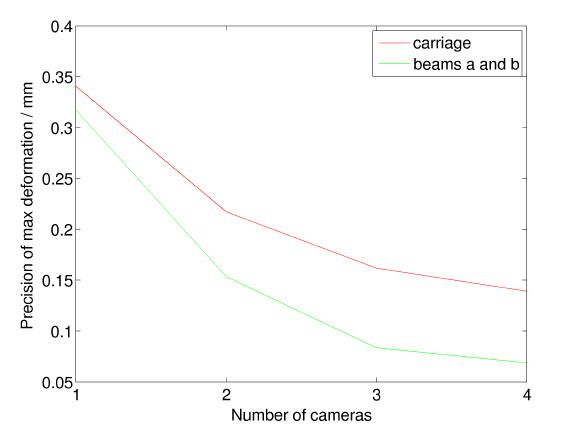
Figure 9: Analytically derived precision of deformation in the middle of the carriage and in the middle of beam a or beam b as a function of the number of cameras.